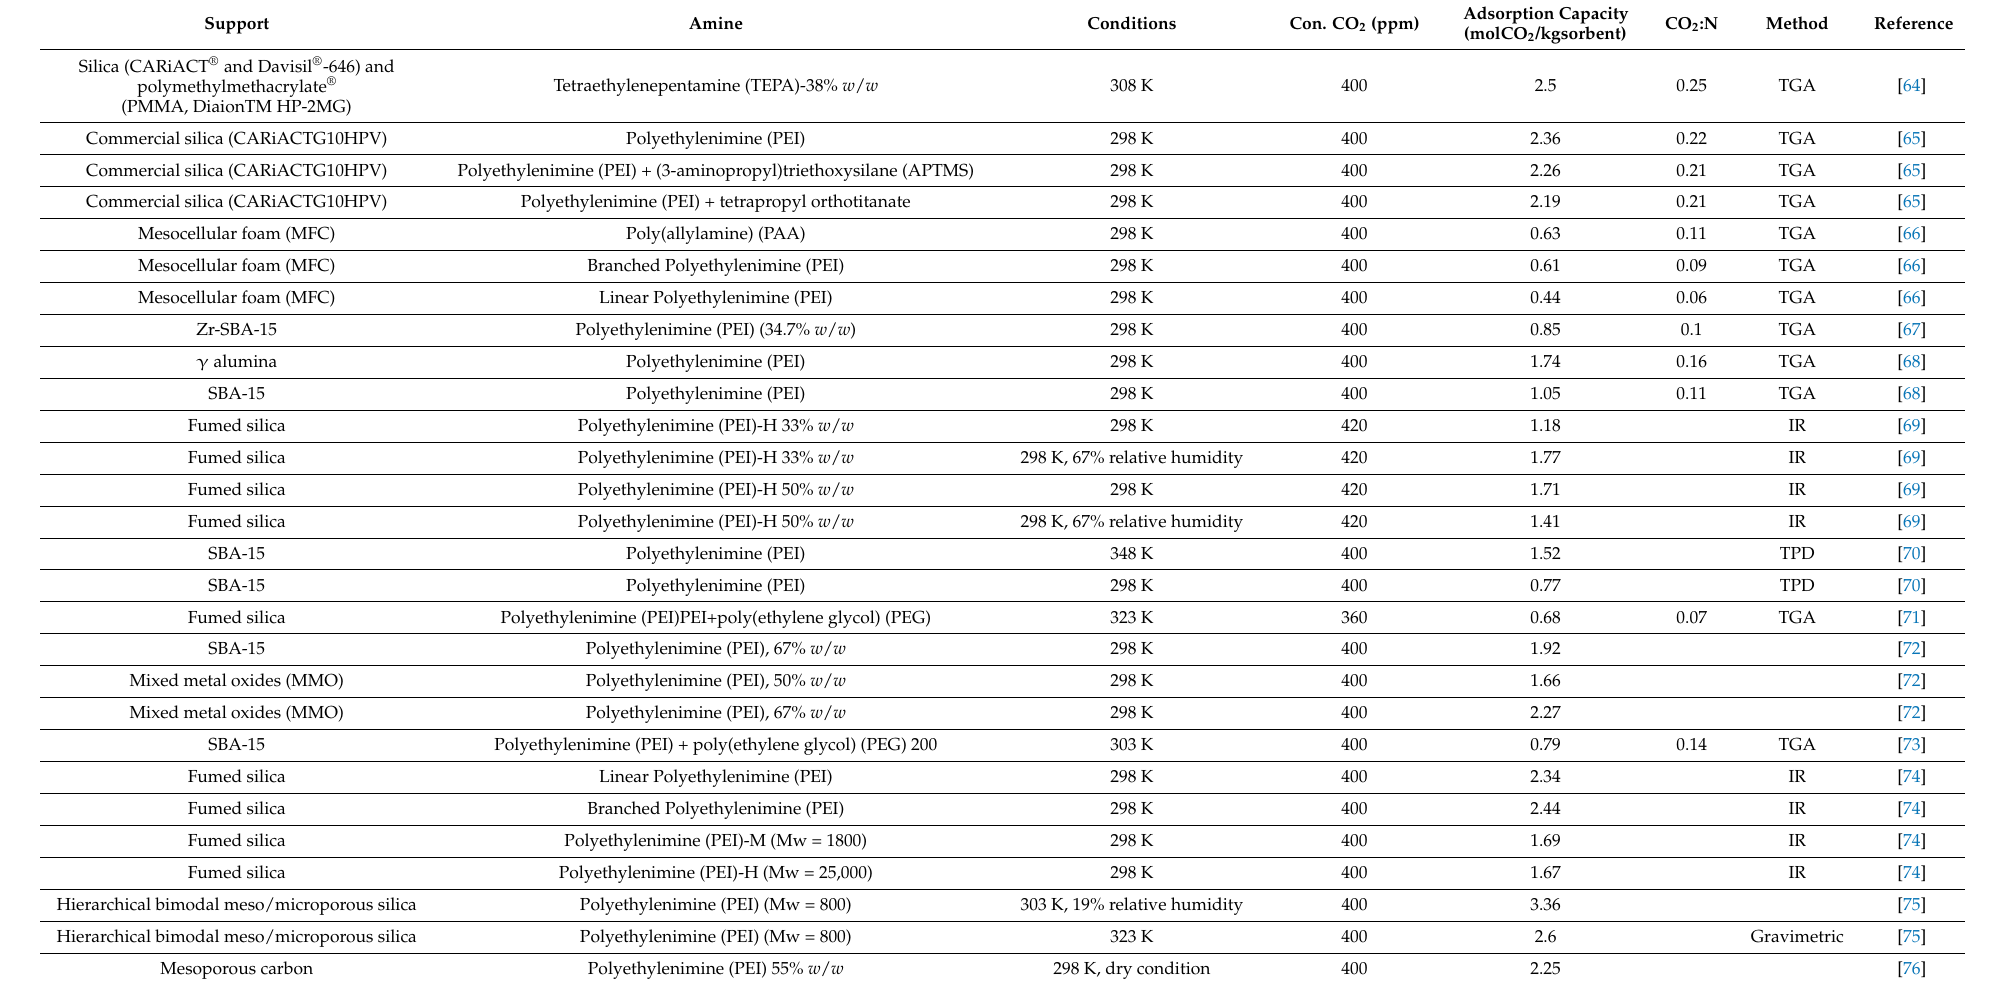
Table 2. Class I amine-functionalized